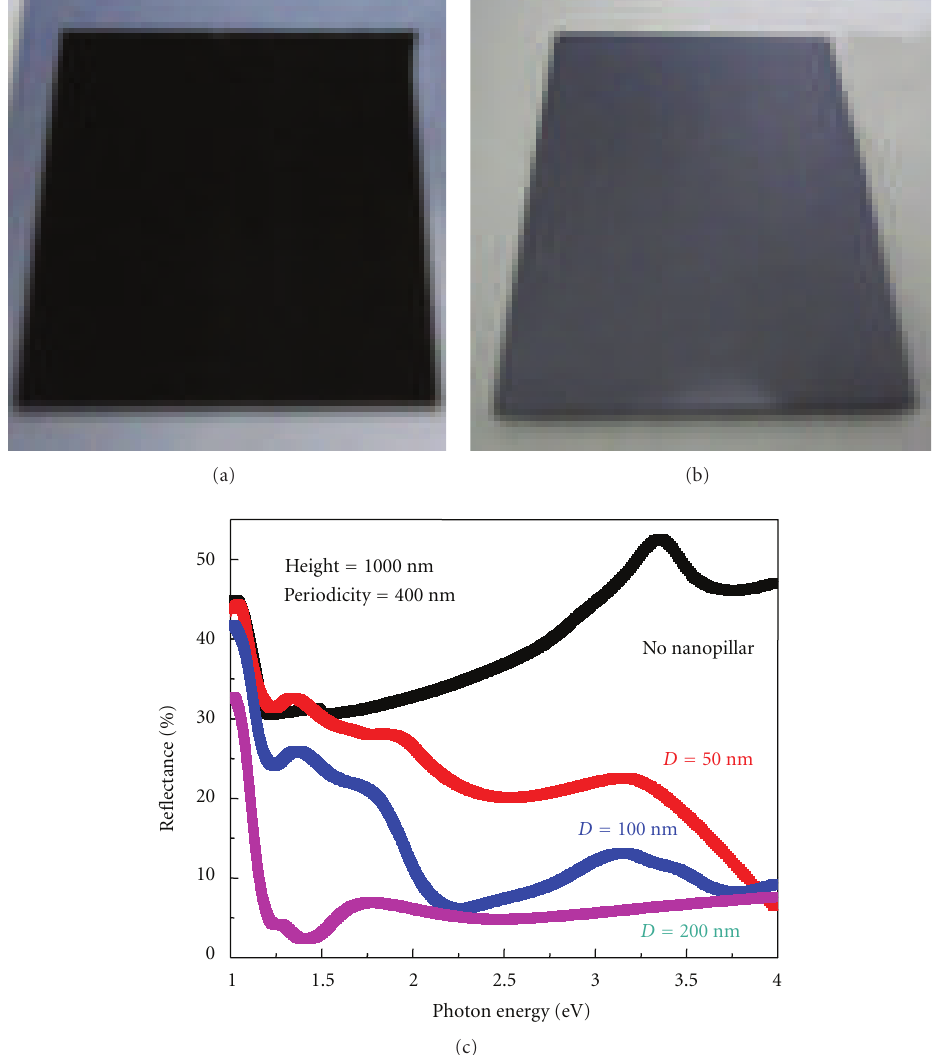
Figure 20: Photographs of (a) SiNP textured and (b) untextured solar cell (without top TCO layer). (c) Reflectance spectra with varying parameters. (Reprinted with permission from [8]. [2010]